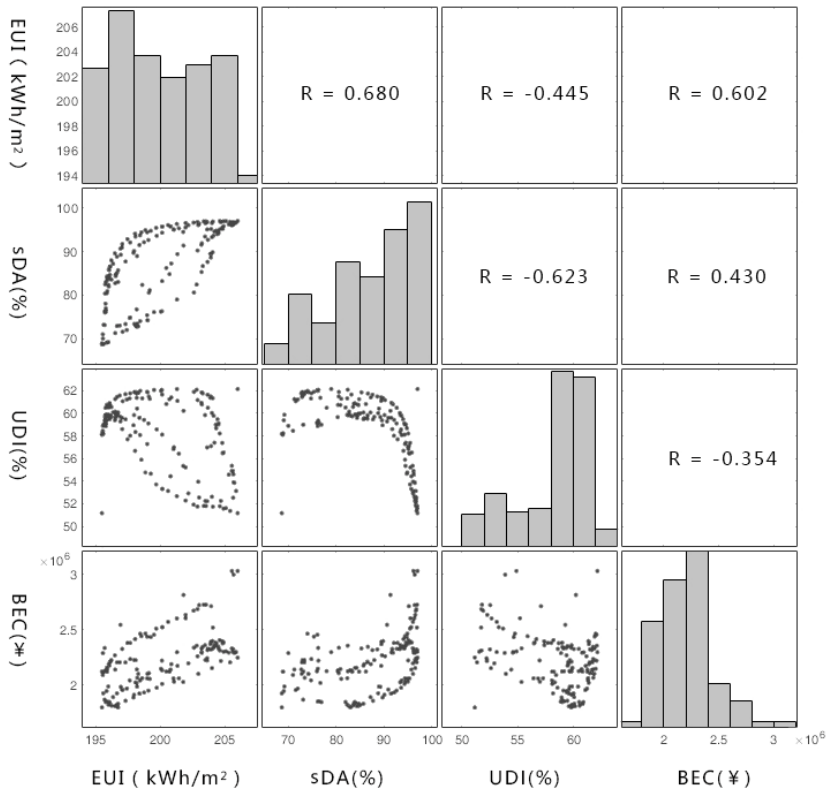
Figure 13. Matrix plot of non-dominated solutions and correlation coefficients between objectives.